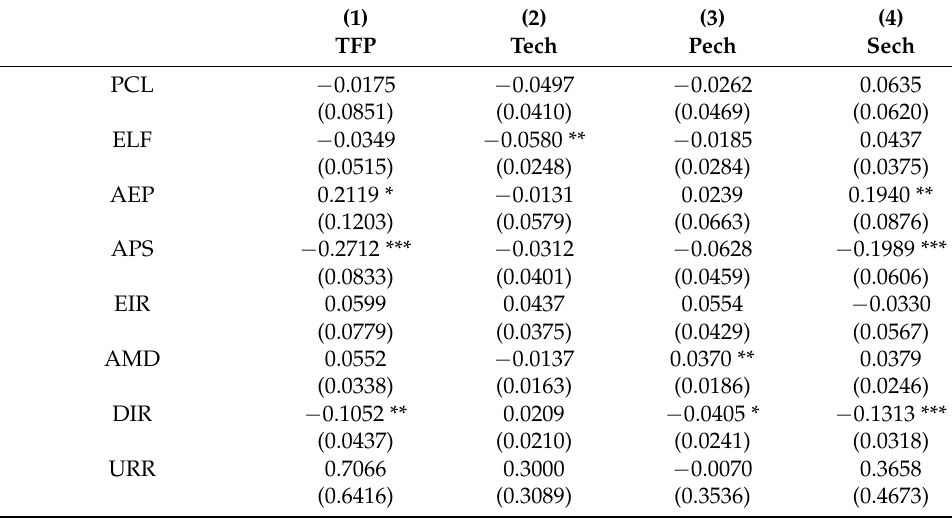
Table 9. Factors Influencing the Productivity of Late Indica Rice and Its Decomposition